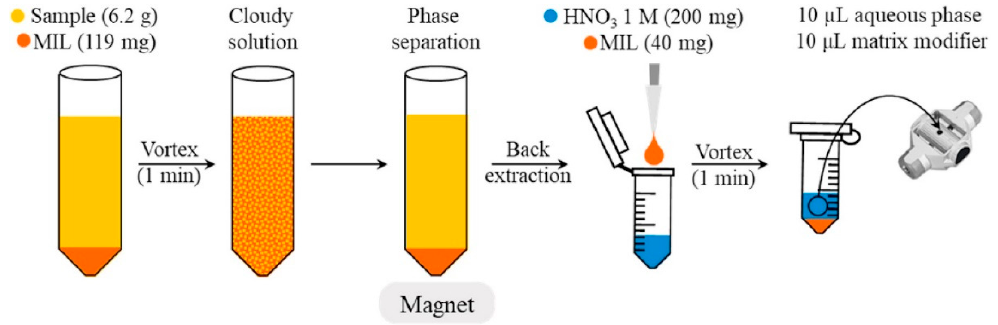
Figure 3. Scheme of the analytical procedure for Cd quantification. Reproduced with permission from [43]. Copyright Elsevier, 2020.